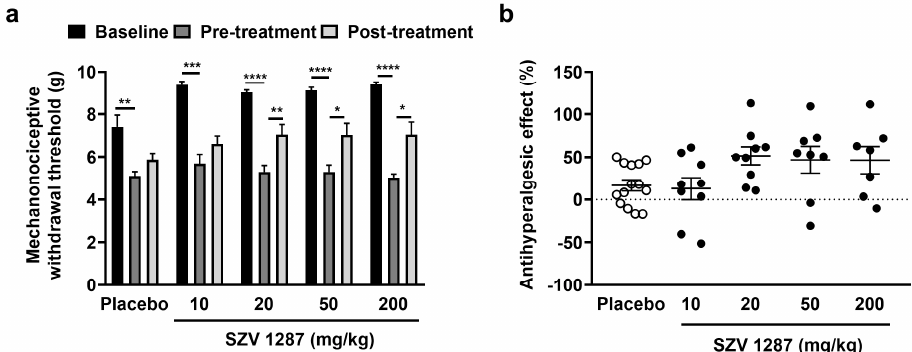
Figure 1. Effect of SZV 1287 on partial sciatic nerve ligation-induced mechanical hyperalgesia following oral dosing in mice. ( a ) Mechanonociceptive withdrawal thresholds and ( b ) antihyperalgesic effects calculated as ((percentage changes of pre-treatment mechanonociceptive withdrawal thresholds compared to the initial controls—percentage changes of post-treatment mechanonociceptive withdrawal thresholds compared to the initial controls)/percentage changes of pre-treatment mechanonociceptive withdrawal thresholds compared to the initial controls) × 100 2 h following single enterosolvent SZV 1287 capsule treatment (10, 20, 50, and 200 mg/kg) on the 7th postoperative day. Data are shown as means ± S.E.M. of n = 7–14 mice/group, * p < 0.05, ** p < 0.01, *** p < 0.001, **** p < 0.0001; repeated measures two-way ANOVA (baseline, pre-treatment, and post-treatment factor F = 137.7, p < 0.0001) followed by Tukey’s multiple comparison